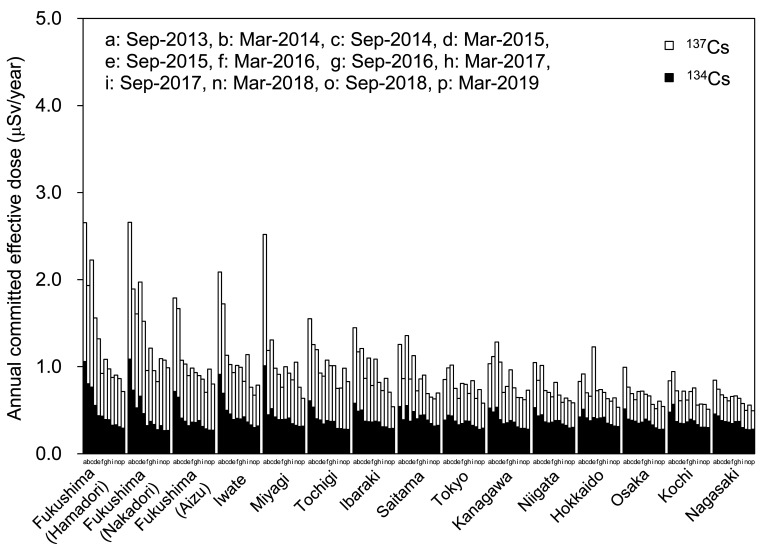
 Time trends of annual committed effective doses of 134Cs and
137Cs in each region. Filled column and opened column indicate the annual
committed effective doses of 134Cs and 137Cs, respectively. For
each region, data are sorted according to the time of study.